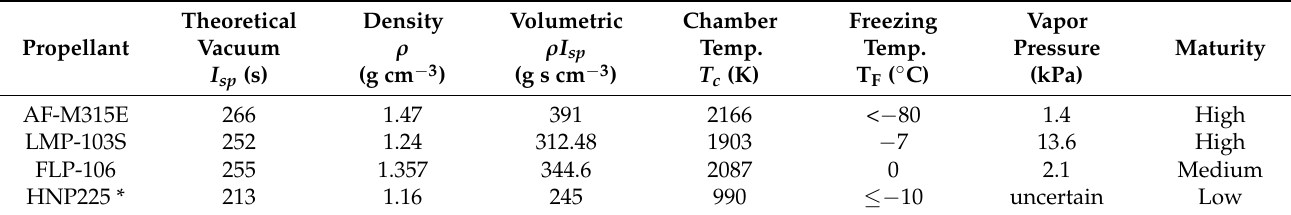
Table 5. Performance and physical properties of the proposed EIL green monopropellants for MIMPS-G500mN [14,16,21,25] as cited in